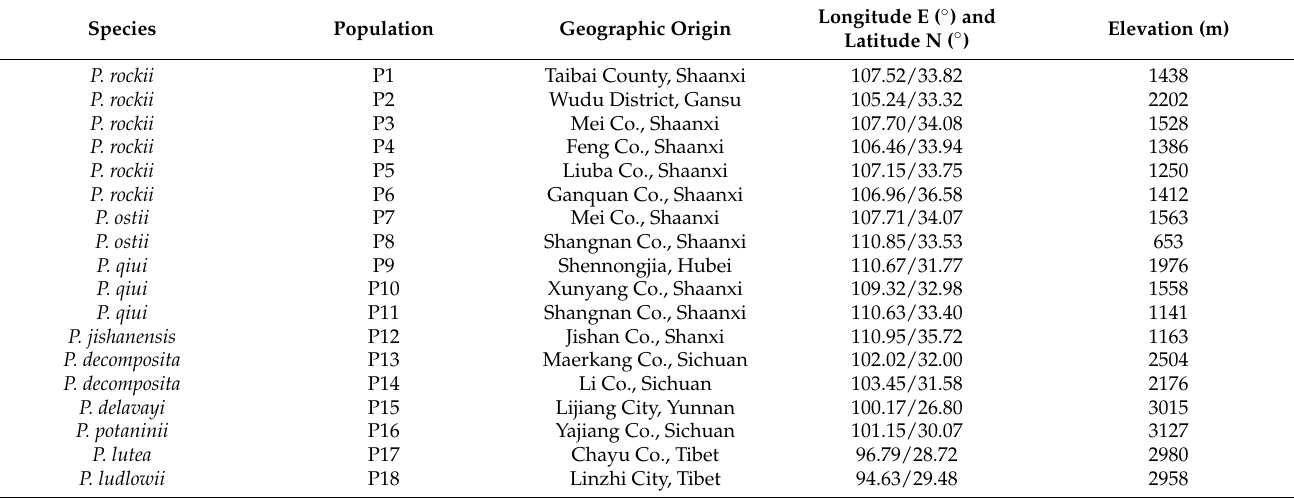
Table 1. Geographic conditions of the original habitat of nine tree peony